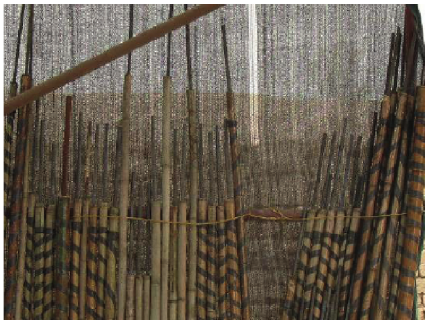
Figure 4: Bolt specimens.